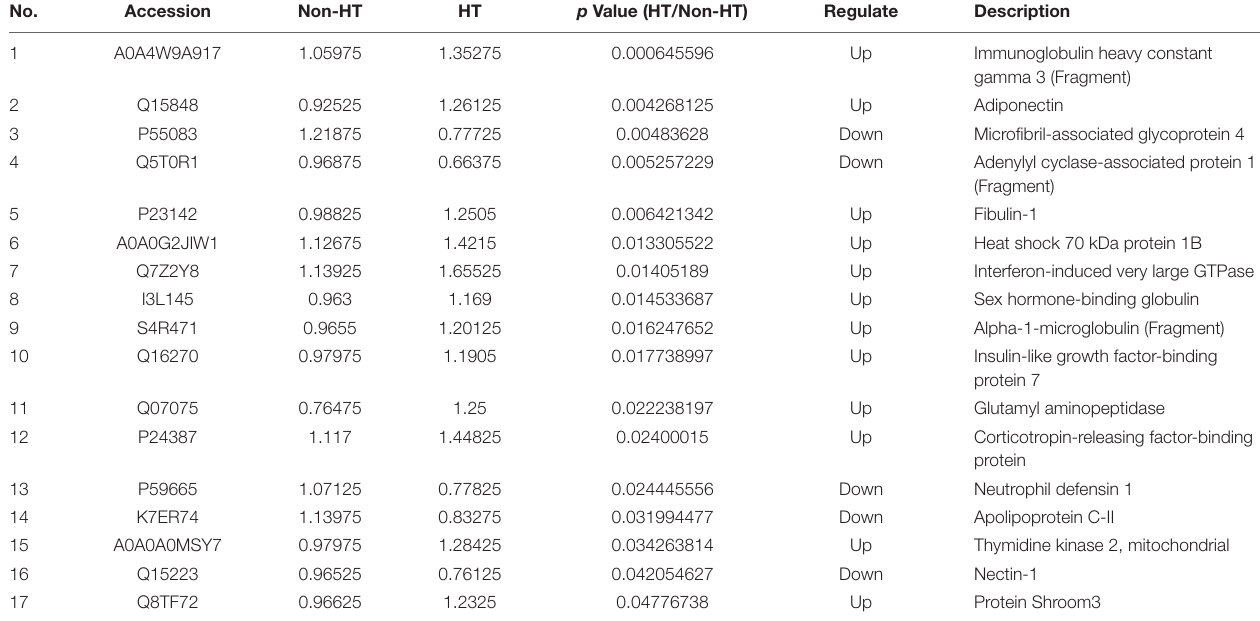
FIGURE 2 | Volcano map of differential proteins between hemorrhagic transformation (HT) and non-HT groups. After isobaric tags for relative and absolute quantitation (iTRAQ) labeling and liquid chromatography coupled with tandem mass spectrometry (LC-MS/MS) identification, 17 differentially expressed proteins were quantified from a total of 647 proteins between HT and non-HT groups. The identified proteins were exported according to the log2 of fold change (HT/non-HT) and p -value. Yellow, upregulated under p < 0.05; red, upregulated under p < 0.01; light blue, downregulated under p < 0.05; blue, downregulated under p < 0.01; black, no significant difference proteins. TABLE 4 | Differential expressed peptides in sera between HT and Non-HT